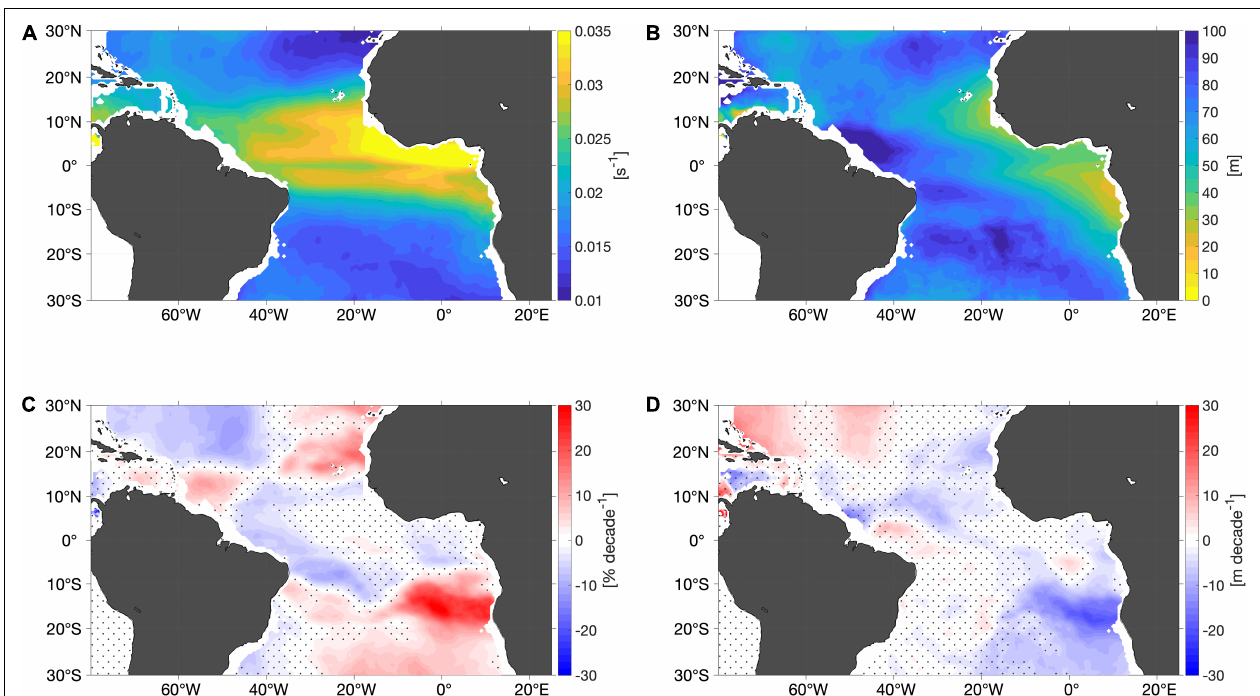
FIGURE 4 | (A) Mean of vertical stratification maxima inferred from Argo for the time period of 2006–2019. (B) Mean depth of the vertical stratification maximum from (A) . Panels (C,D) decadal trend of (A,B) , respectively. Trends are computed from the anomalies relative to the seasonal mean. Please note, positive trend of depth refers to a deepening. Areas where the trend is not of 95% significance are stippled. Shelf regions below 2,000 dbar are blanked